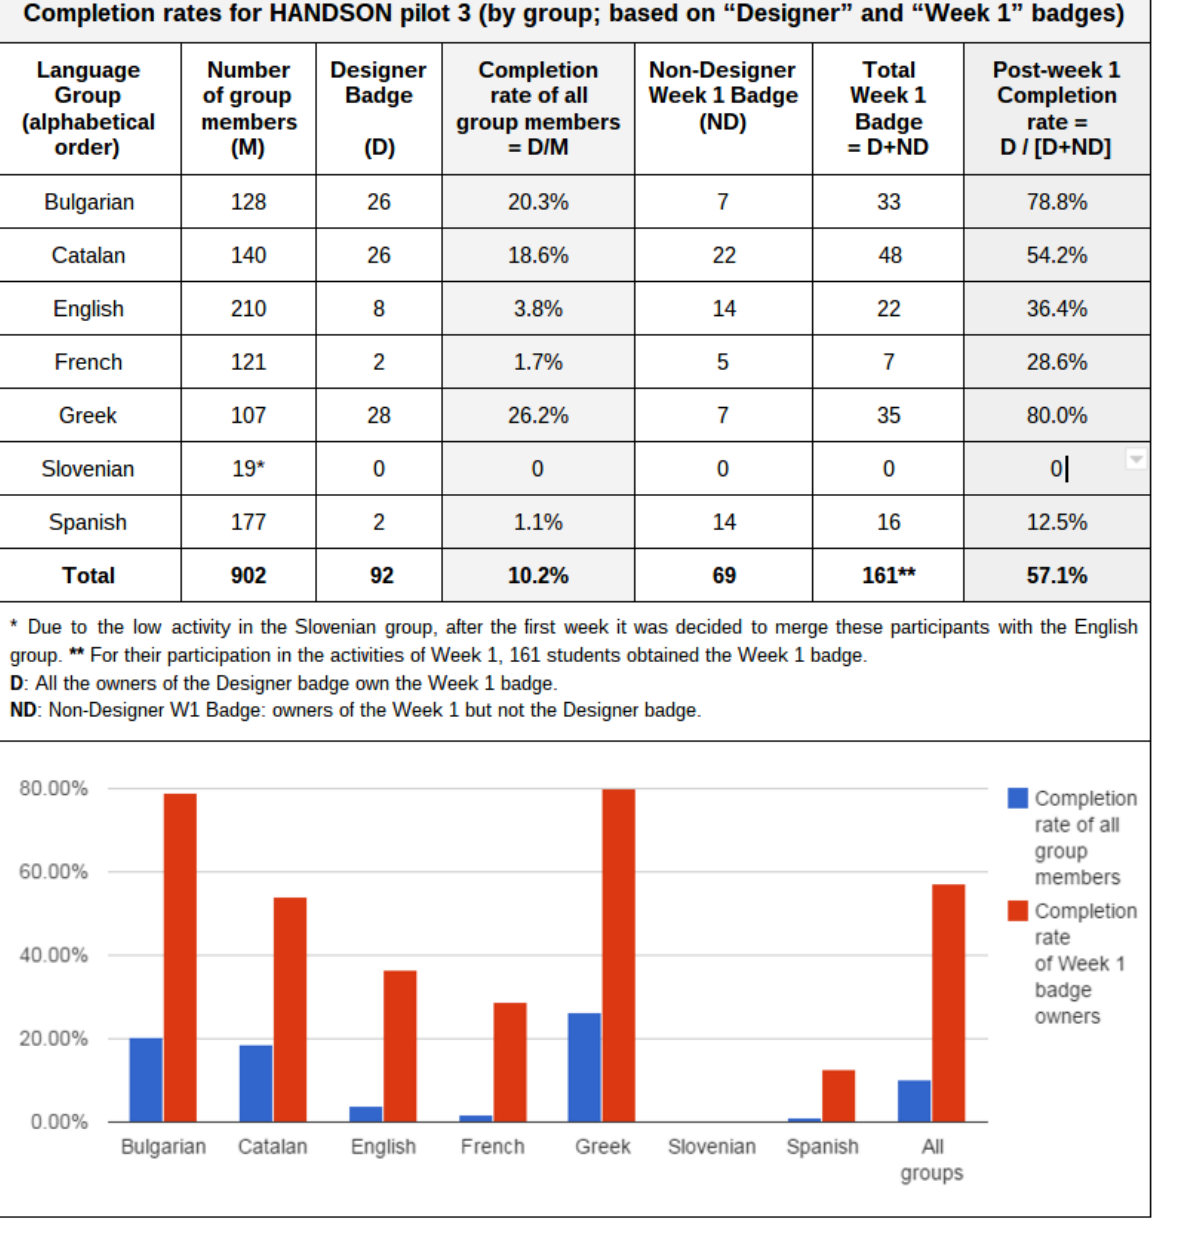
Figure 10 . Completion rates for the seven language